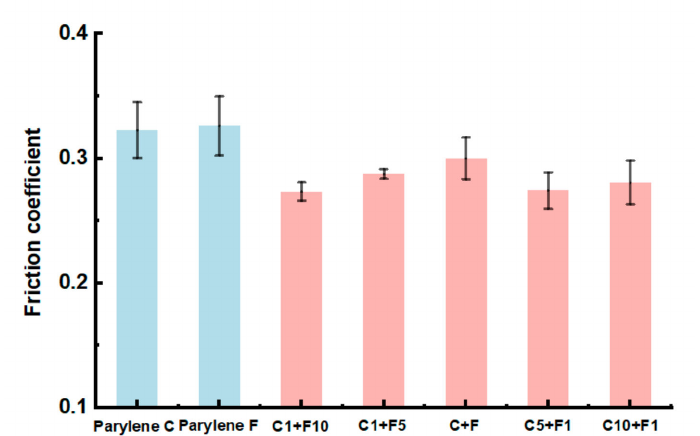
Figure 6. Friction coefficient results of the Parylene homopolymer and copolymer films. The copoly- mer Parylene films possessed smaller friction coefficient results compared to that of homopolymer Parylene films.